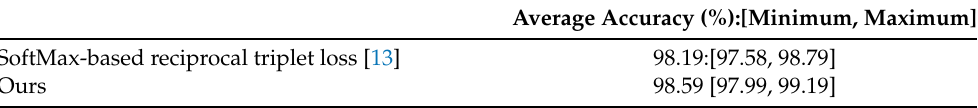
Table 4. Result on OpenCow2020 with 50% individuals